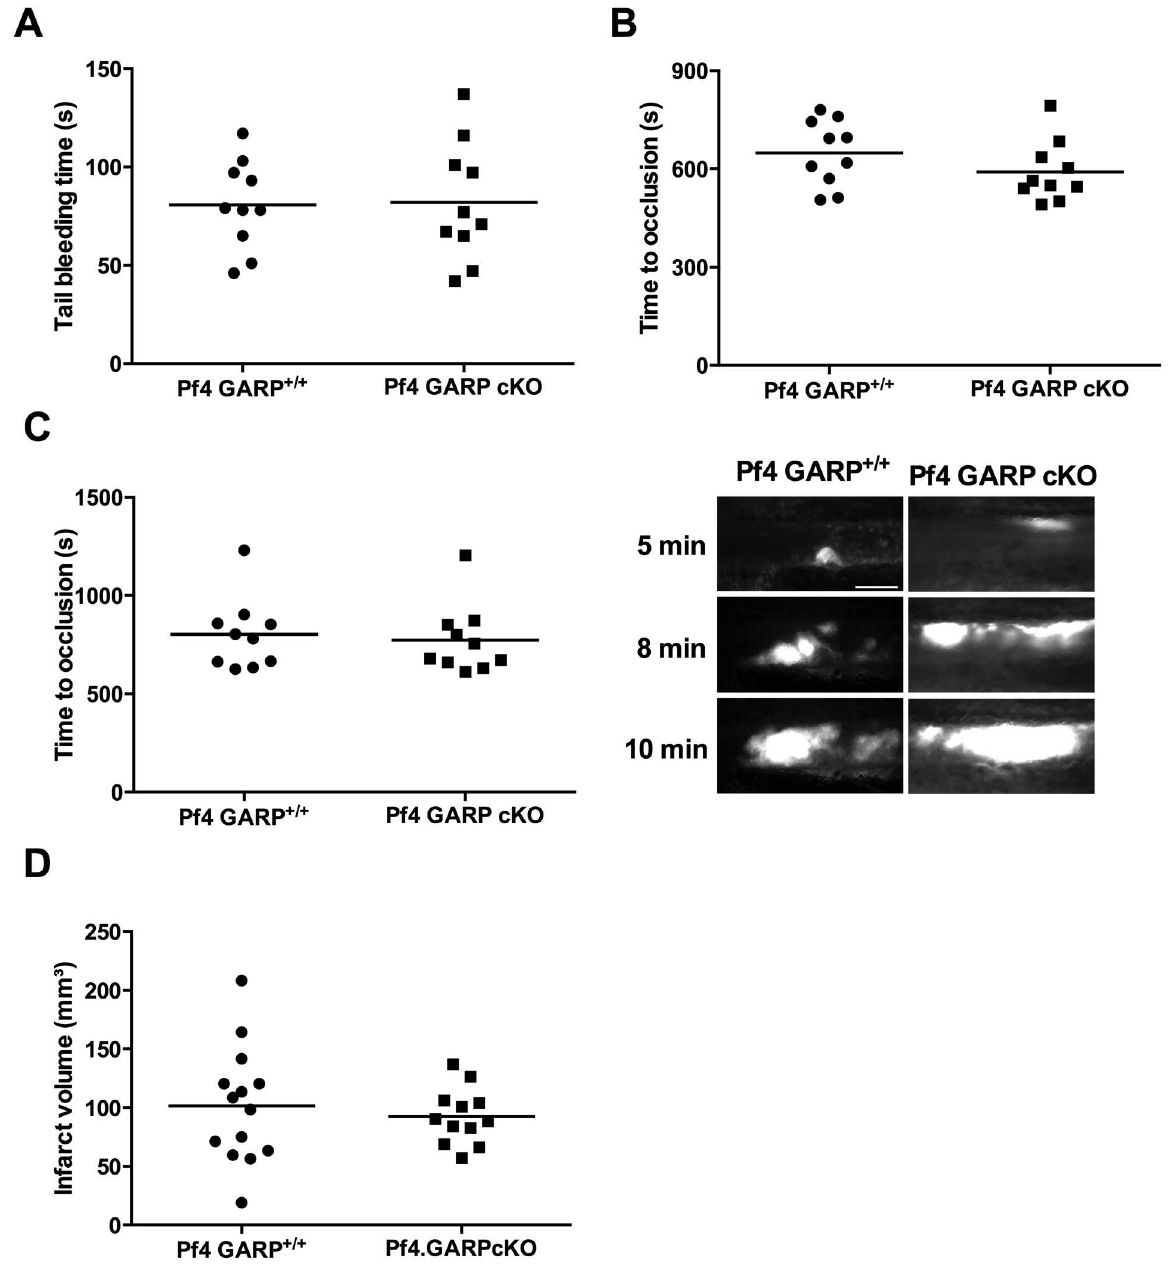
Fig 4. Unaltered bleeding time and thrombus formation in Pf4 specific GARP cKO mice. ( A ) 2 mm of the tail tip was dissected and tail bleedingtimes were measured(n = 10). ( B ) Carotid artery was injuredusing topical application of 12% FeCl 3 and blood flow was monitoredusing a flow probe until flow stoppeddue to the formation of an occlusivethrombus (n = 10). ( C ) Mesenteric arteries were injuredusing 10% FeCl 3 and thrombus formation was followedusing intravital microscopyuntil full occlusionwas reached (n = 10). Representative pictures after 5, 8 and 10 min of mesenteric thrombus formation are shown on the right. Scale bars represent 50 μ m. (D) The right middle cerebralartery of littermate mice (n = 14) and platelet specific GARP knockoutmice (n = 12) was occluded during 60 min and reperfusionwas allowedduring23